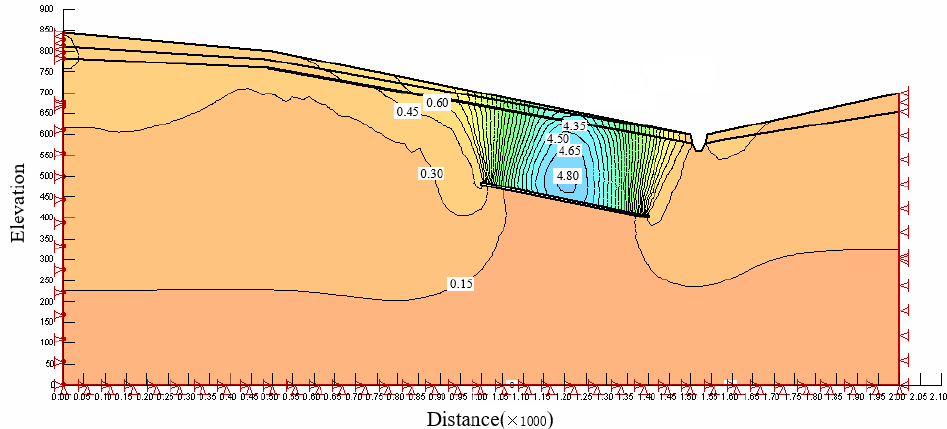
Figure 12. Y-direction displacement contour map of slope before sliding. (2)